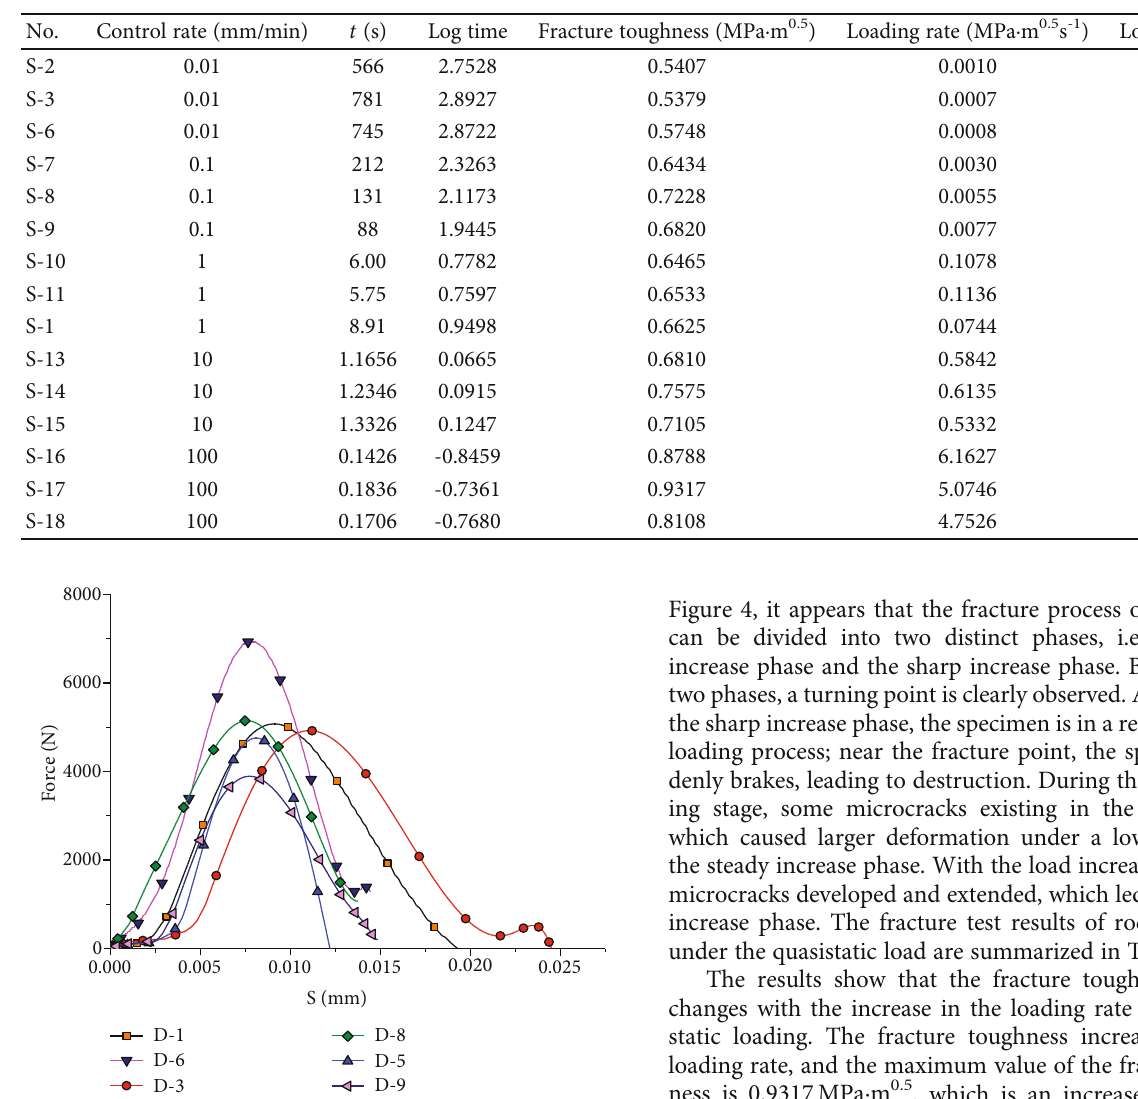
Table 1: Fracture test results of rock specimens under the quasistatic load.